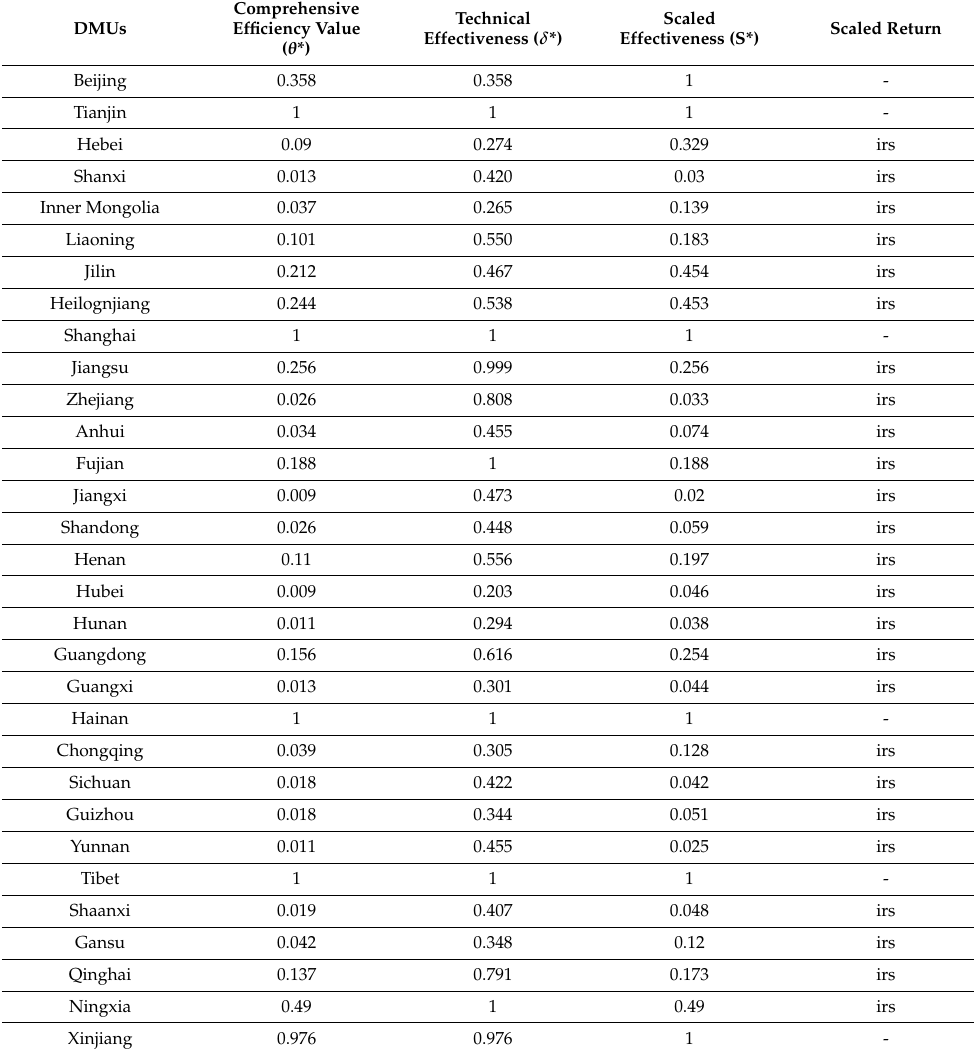
Table 5. DEA efficiency values of natural disaster mitigation and reduction in China in 2019. DMUs